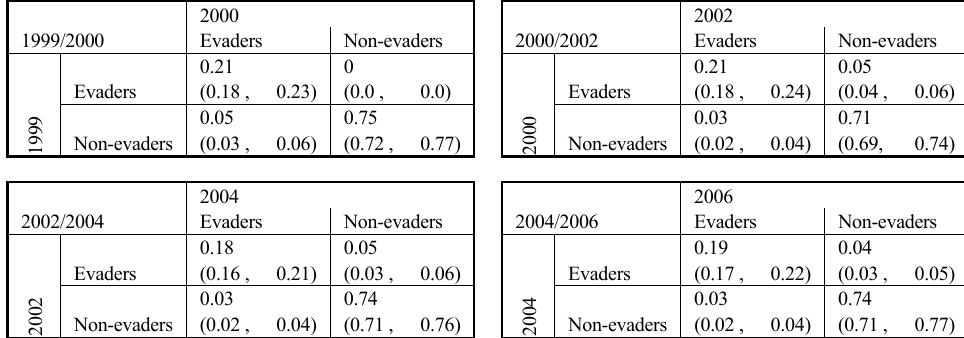
Table A.2 : Estimated Short-Term Transition Matrices, with 95% Confidence